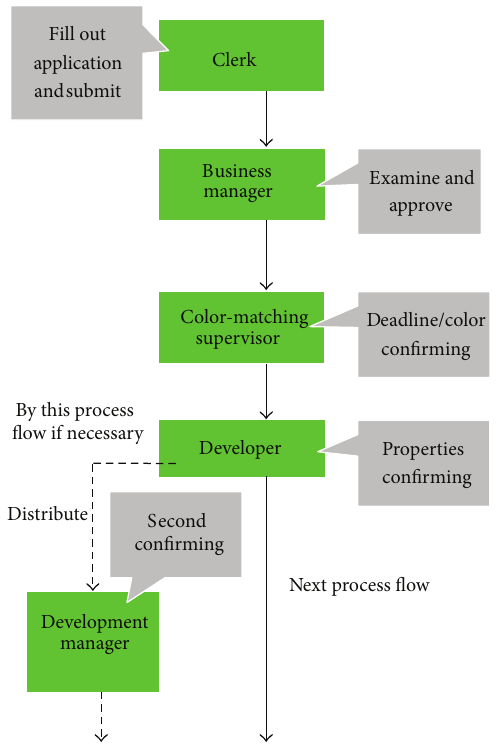
Figure 3: Flow chart of formula/technology and planning and constructing